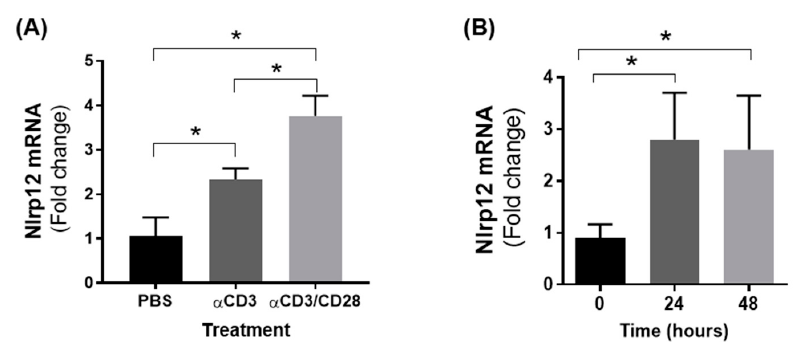
Figure 4. T cell activation increases Nlrp12 mRNA expression. ( A ) Increased expression of Nlrp12 mRNA in CD4 + T cells activated with anti-CD3 or anti-CD3/CD28 antibodies for 24 h. The higher expression was found in T cells activated with anti-CD3/CD28 antibody compared to T cell treatment with anti-CD3 or PBS; ( B ) The expression of Nlrp12 is increased in activated CD4 + T cells after 24 and 48 h activation with anti( α )-CD3/CD28 antibody; results are presented relative to the expression of Nlrp12 in inactive cells; n = 4, * p < 0.05.